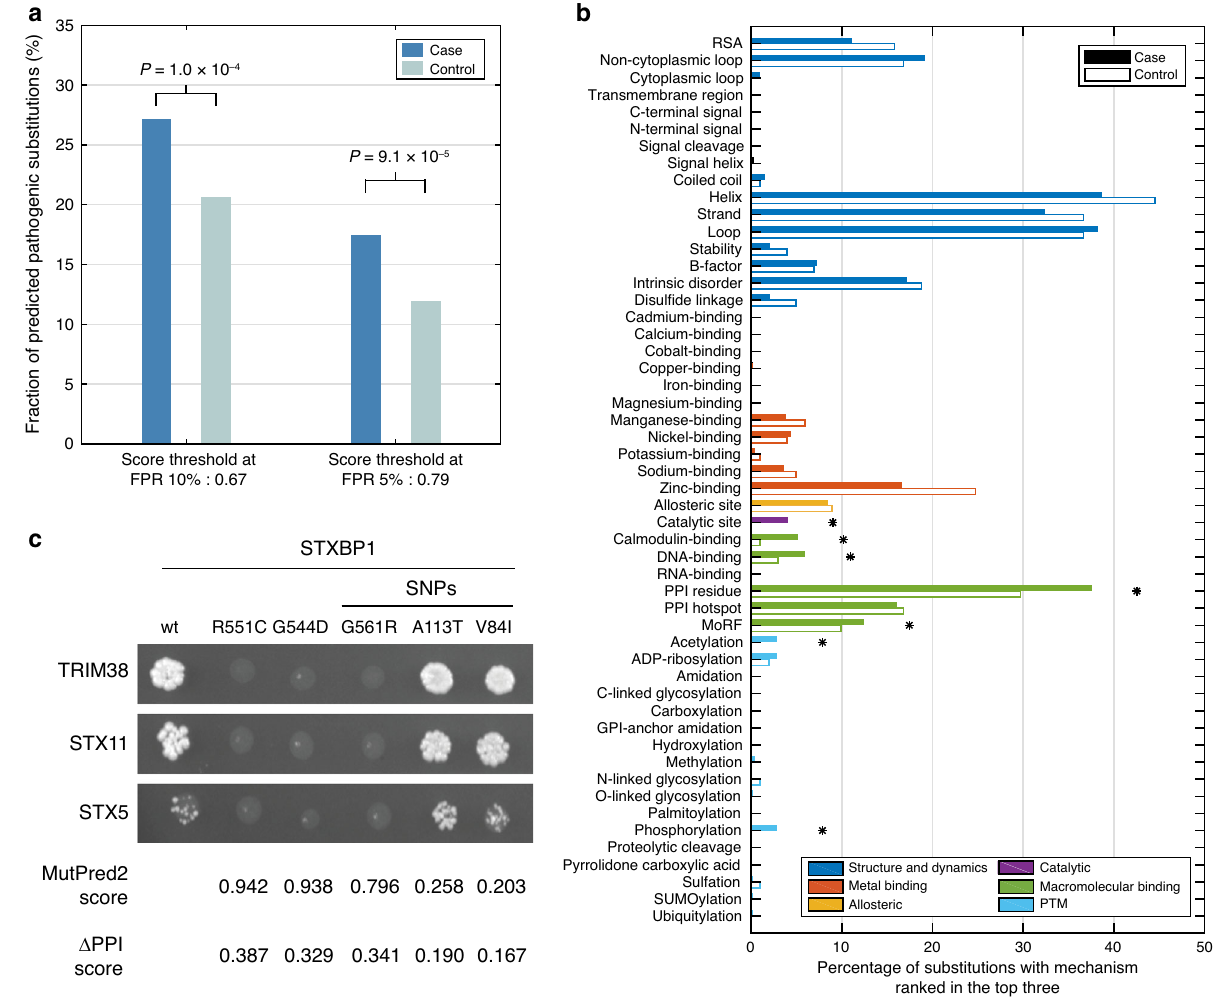
Fig. 4 Summary of MutPred2 predictions on de novo missense mutations from four neurodevelopmental disorders. After removing genes with mutations shared by both case and control sets, subsequent analyses were based on 2986 and 844 mutations from the case and control sets, respectively. a Proportions of case and control mutations predicted to be pathogenic by MutPred2 at thresholds corresponding to false-positive rates (FPR) of 10% and 5%, respectively. P values were computed using a two-tailed Fisher ’ s exact test. Odds ratios and P values for other thresholds are shown in Supplementary Fig. 7. b Enrichment of structural and functional signatures of case mutations versus the control group. Only those mutations considered to be pathogenic at the 5% FPR threshold were included in this analysis. Properties are grouped based upon their broader classes as described in the ontology (Fig. 1b). Statistical signi fi cance was assigned at α = 0.05 using a one-sided binomial test with Benjamini – Hochberg correction and represented by asterisks. c Representative images of 3AT selection plates with the interaction pro fi les of STXBP1 against TRIM38, STX11, and STX5. Pathogenicity scores and probability of alteration of protein – protein interactions (PPIs) corresponding to each mutation are shown. The PPI alteration probability of >0.5 × (1 – 0.5) = 0.25 is considered to be high